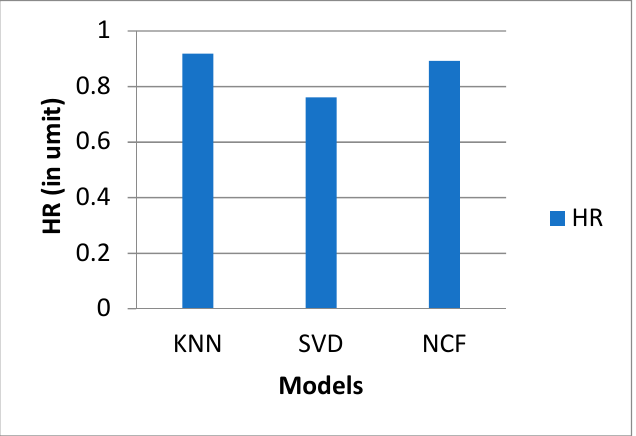
Figure 10. Performance results of different models in terms of HR in 70:30 training–testing scenario.